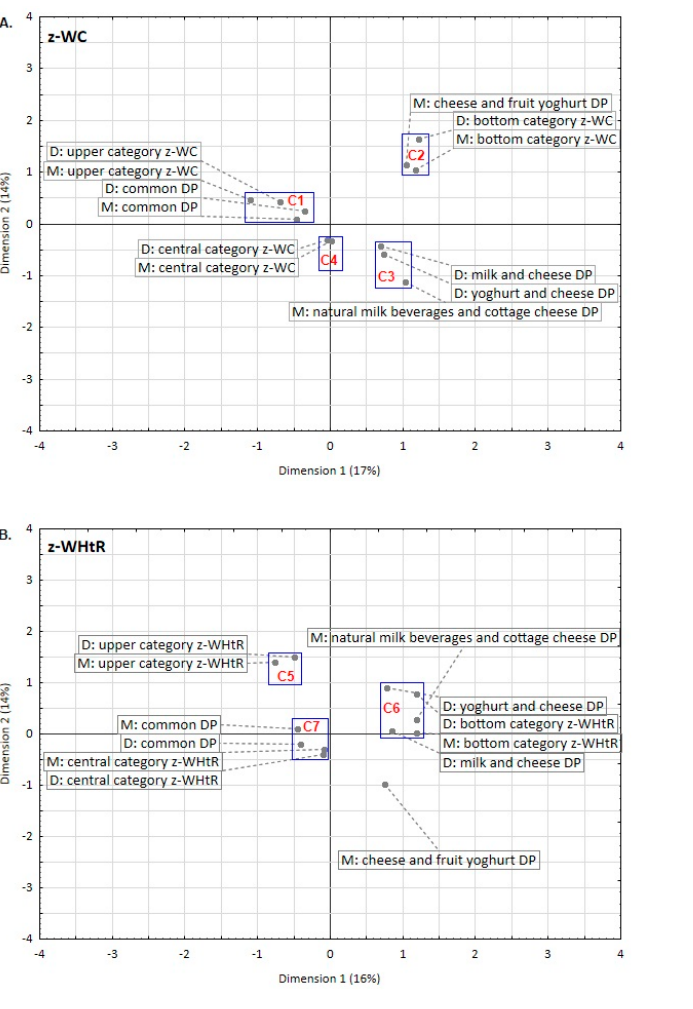
Figure 2. Graphical projection of a multiple correspondence analysis of the associations between body weight and composition z -characteristics and dairy-related dietary patterns (variance explained by each dimension). Notes: DP: Dietary pattern.